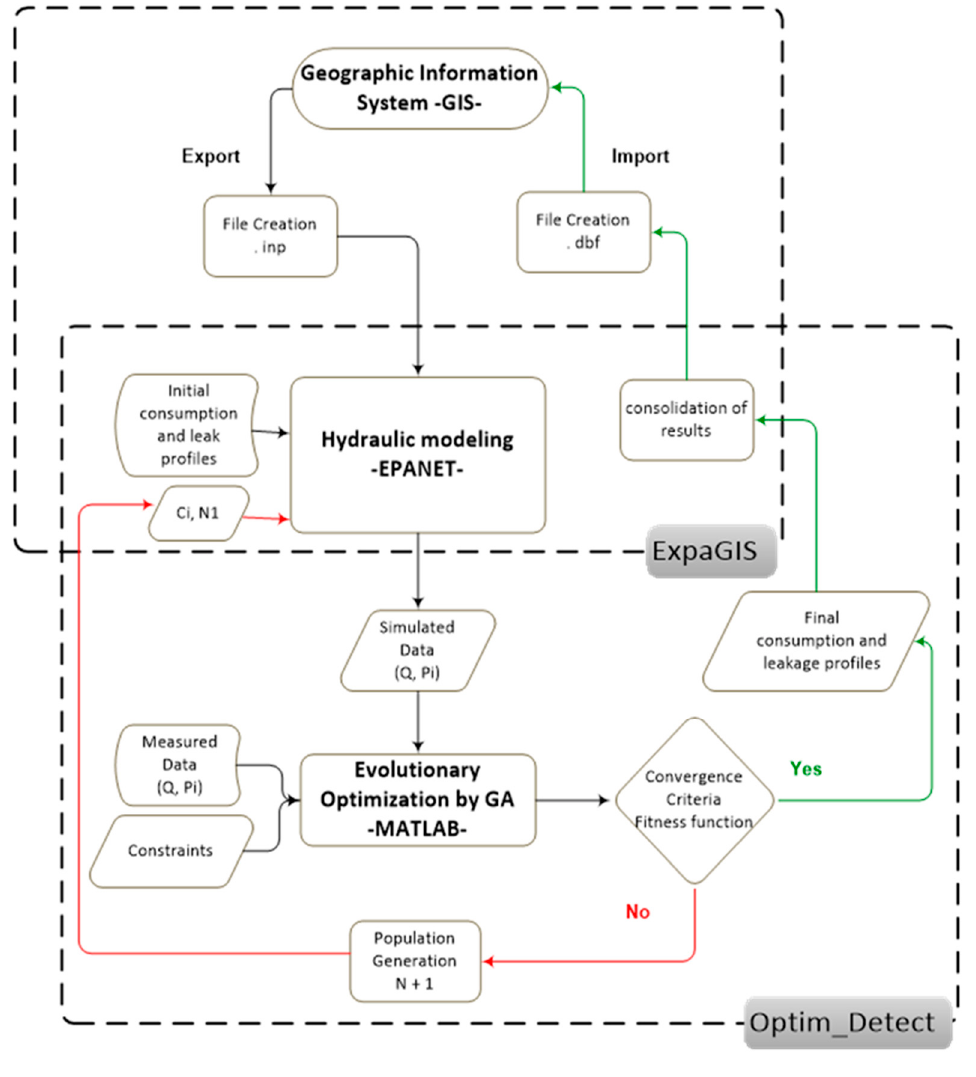
Figure 2. Leak pre-localization